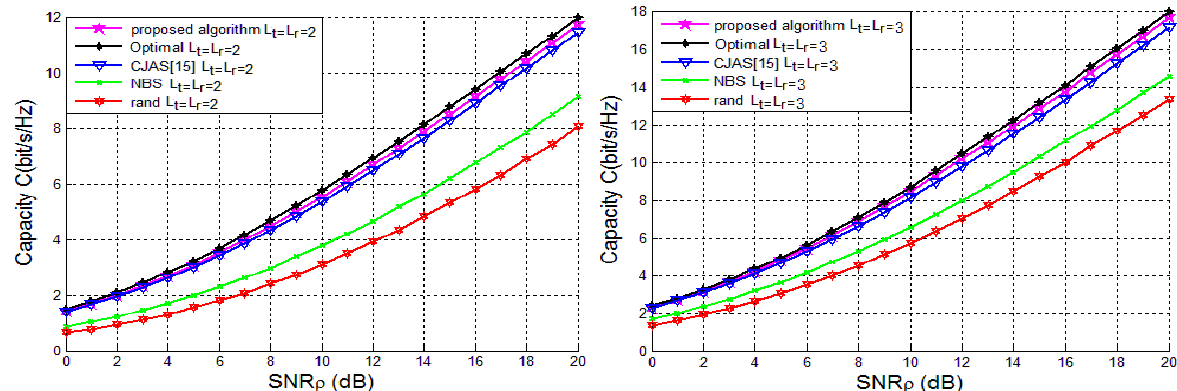
Fig. 4 statistical capacity versus SNR for { 5 , 2;5 , 2 } system